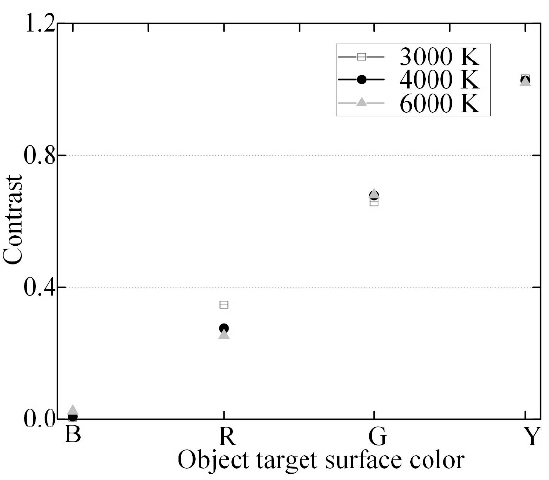
Figure 15. Relationship between target contrast and target surface color for different LED CCTs.